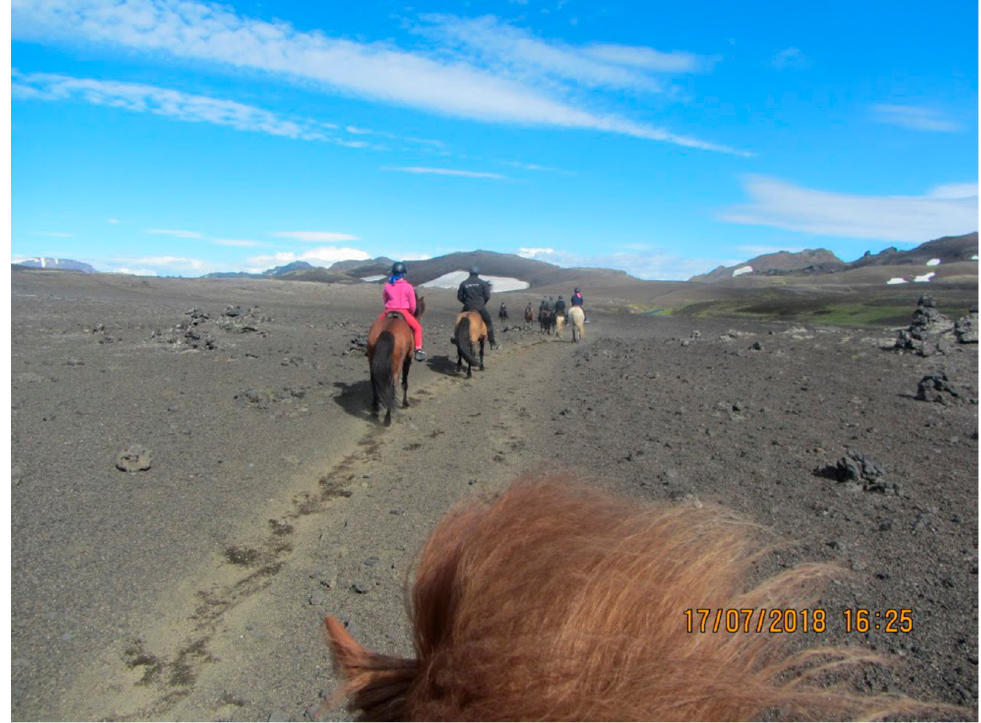
Figure 1. Riders in the highlands of Iceland. Photo: Ingibjörg Sigurðardóttir.